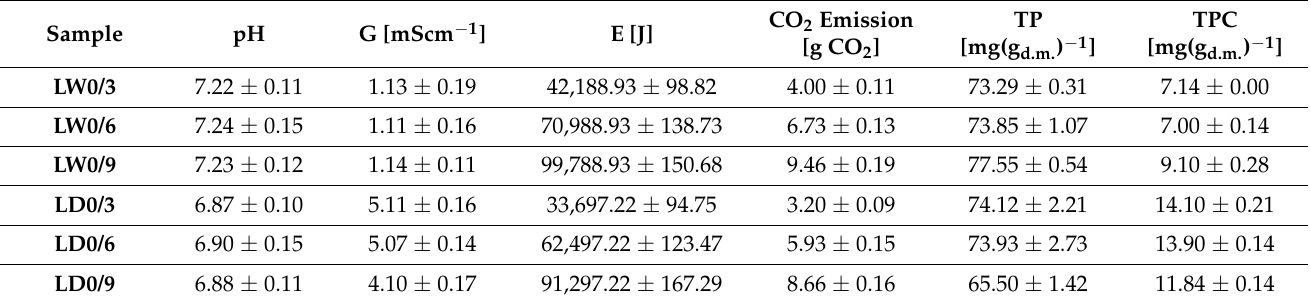
Table 5. Results of pH value, electrical conductivity, energy, CO 2 emission, power, total protein, and total phenols content for LD0 and LW0 samples.